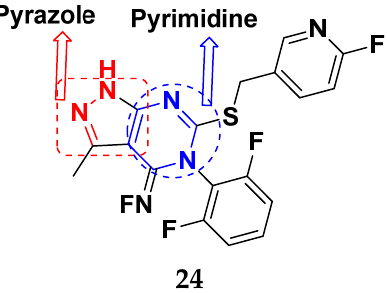
Figure 28. A pyrimidine hybrid ( 24 ). Tanaka et al. (2012) synthesized and patented pyrimidine-pyrazole based hybrid molecules and evaluated their anticancer activity as Fyn inhibitors. Among the synthesized compounds, compound 25 (Figure 29) showed excellent activity with an IC 50 of 3 nM. Furthermore, 26 (Figure 29) showed excellent activity on carbonyl reductase 1 with an IC 50 of 28 nM [76].